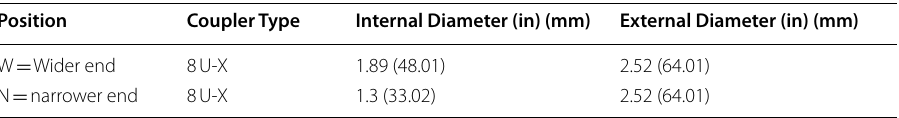
Table 2 Details of splice sleeve number 8 U-X (ICC-ES Report 2016) Position Coupler Type Internal Diameter (in) (mm) External Diameter (in) (mm) W Wider =